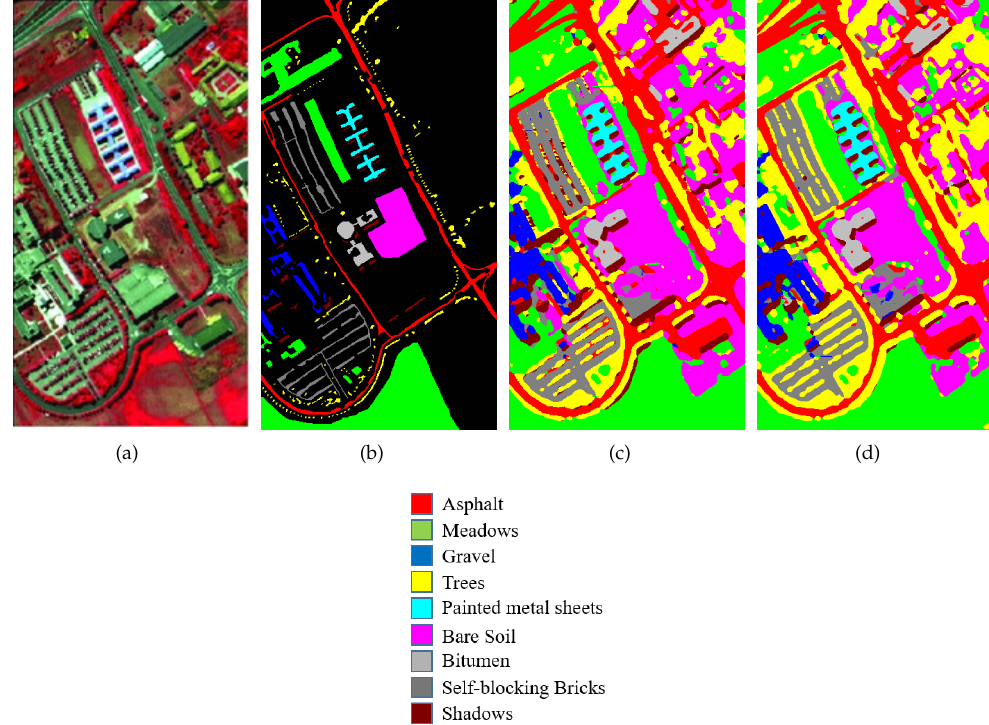
Figure 8. Visual classification results on the PU dataset. ( a ) A three-band color composite image, ( b ) the ground-truth image. Classification results of input image patch size ( c ) 7 × 7, ( d ) 11 ×